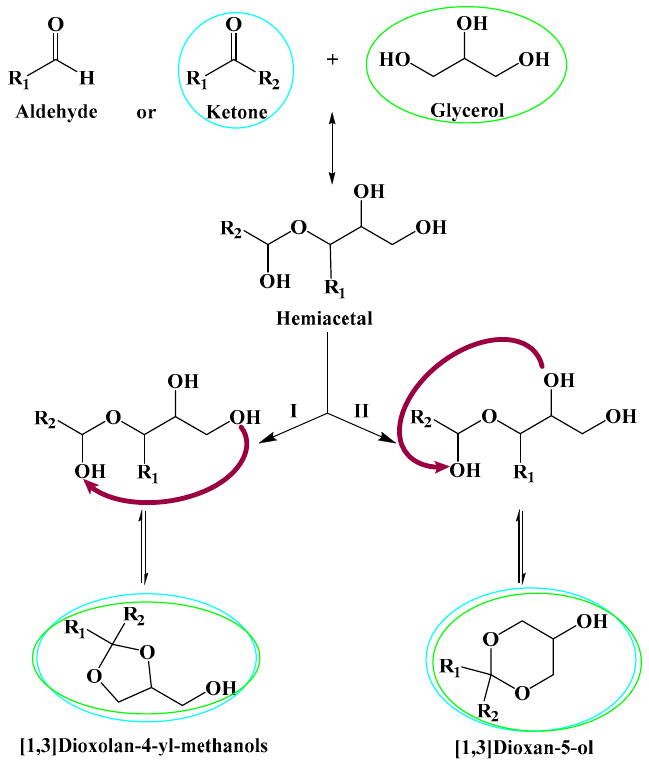
Scheme 5. Probable reaction pathway of solketal isomers